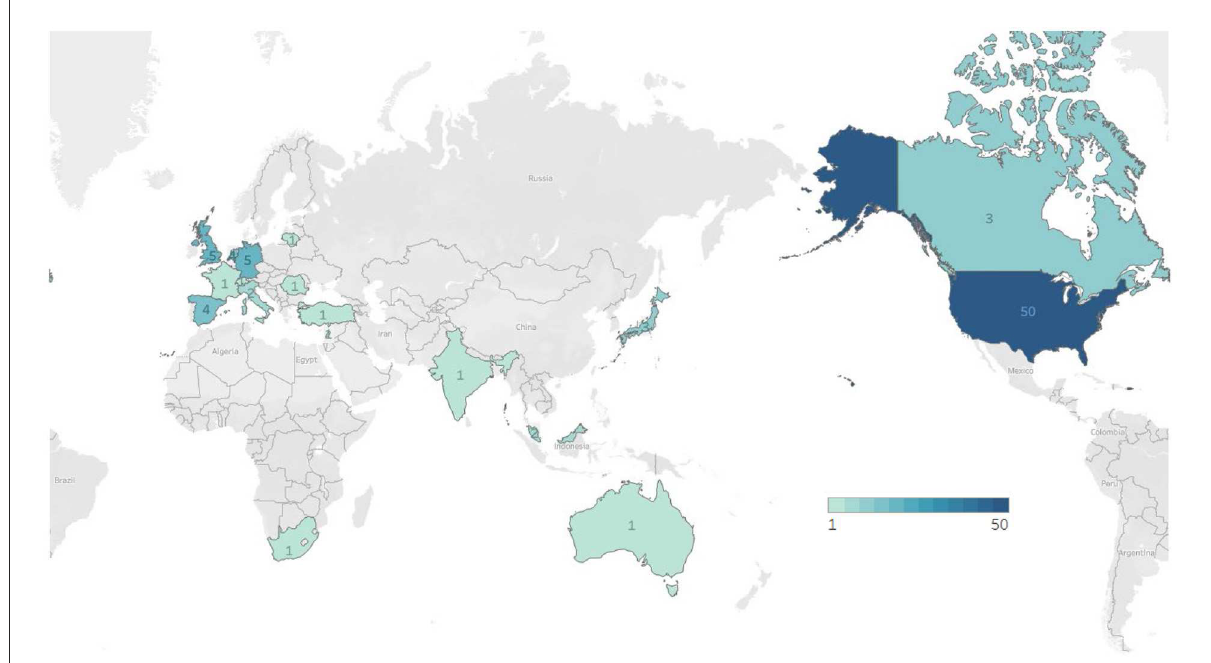
FIGURE3 Number of articles reporting a metric, specifically a term and unit, to describe solar energy-land relationships by country of corresponding author origin ( n = 18) in the SCOPUS database from 1977 to 2019.